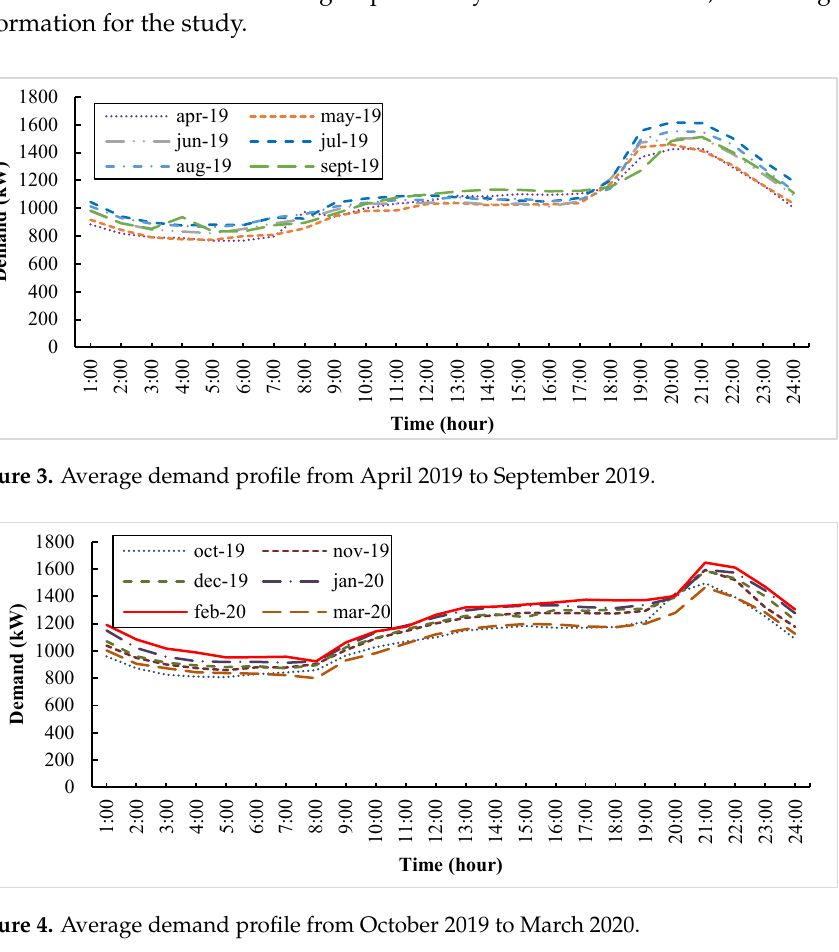
Figure 4. Average demand profile from October 2019 to March 2020.